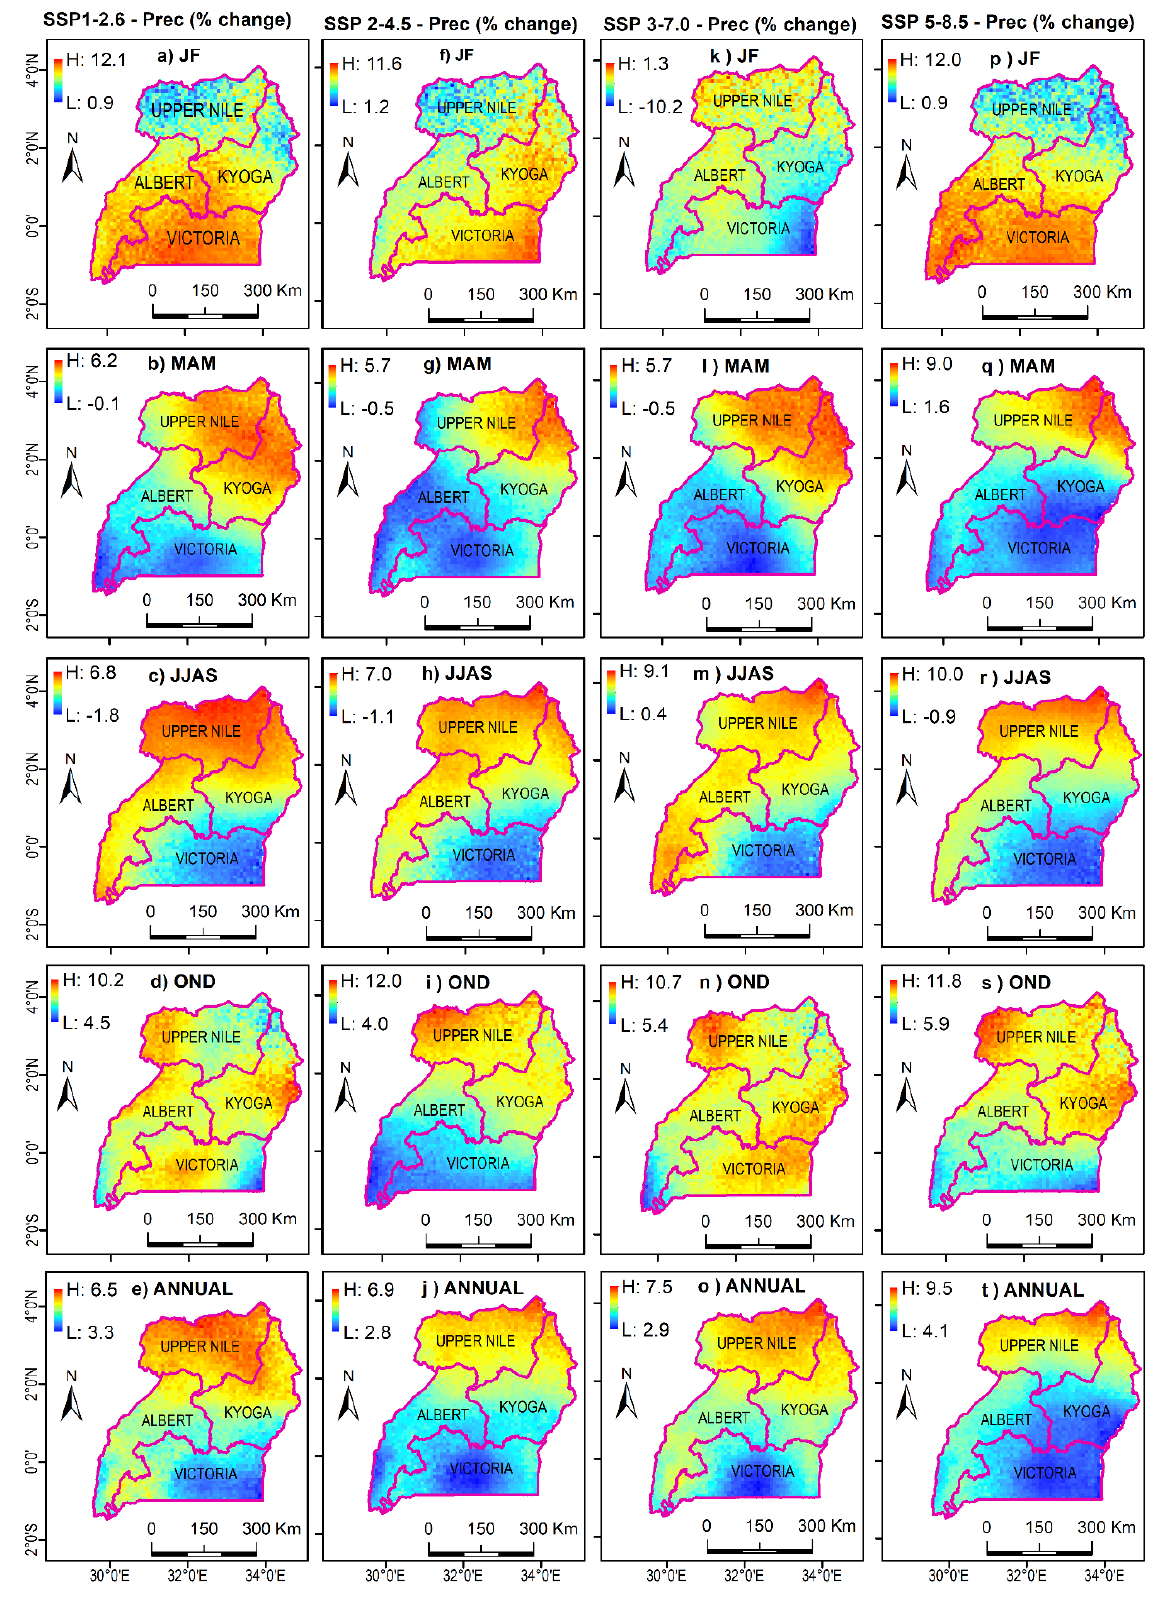
Figure 3. Projected percentage changes in ( a , f , k , p ) JF, ( b , g , l , q ) MAM, ( c , h , m , r ) JJAS, ( d , i , n , s ) OND, and ( e , j , o , t ) annual precipitation for the 2030s based on ( a – e ) SSP1-2.6 ( f – j ) SSP2-4.5, ( h – o ) SSP3-7.0, and ( p ) SSP5-8.5. Averaged climate change projections for precipitation over each WMZ can be seen in Figure 4. A substantial change in precipitation will occur towards the end of the 21st century; 2090s, under SSP3-7.0 and SSP5-8.5 relative to the baseline period (Figure 4d). The period 2030s and 2050s show that the region will experience <10% increase in precipitation in most WMZs, while a pronounced increase is noted during the 2070s until the end of the century. Whereas JF season is considered as a dry anomaly in present